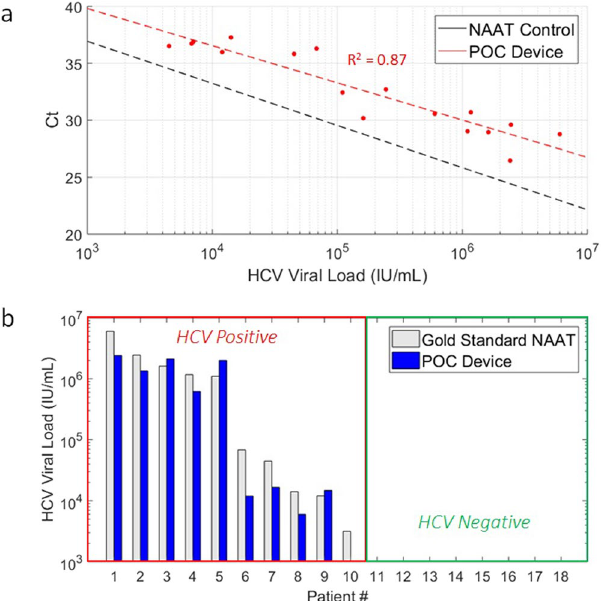
Figure 6. Clinical serum viral load evaluation. ( a ) Standard curve for threshold cycles versus HCV RNA input generated from cartridge (red) compared to standard curve obtained from NAAT control conducted on a benchtop thermocycler (Fig. S7). Nine HCV-infected clinical blood serum samples (undiluted and 10% serum in water, n = 18) were injected into cartridges in 10 µ l aliquots. The limit of detection was found to be approximately 45 IU of HCV RNA. ( b ) Measurement of HCV RNA from 10 µ l undiluted serum samples using DM-PCR assay cartridges. Estimates of HCV IU (blue bars) were calculated by substituting Ct values from each cartridge PCR test into the fitted relationship represented by the dotted red line in ( a ). The actual values (gray bars) were based on HCV IU concentrations for each patient reported by clinical laboratory processing. Only patient 10 with the lowest viral load (3,160 IU/ml) went undetected out of all positive samples (n = 10). No false positives were detected through cartridge processing of the cleared HCV negative patient samples (n =